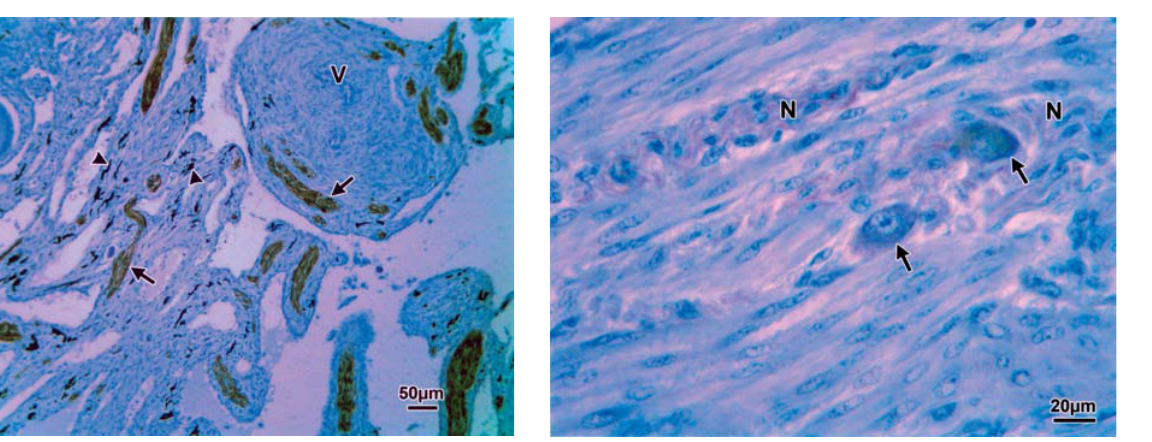
FIG. 4 NSE immunoreactive neuronal cell bodies (arrows) in the medulla. N: nerve bundle